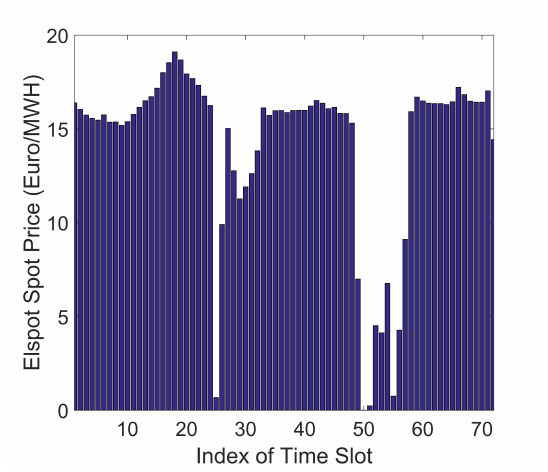
Figure 6. Electricity prices in 72 time slots. For each slot, it presents one hour.